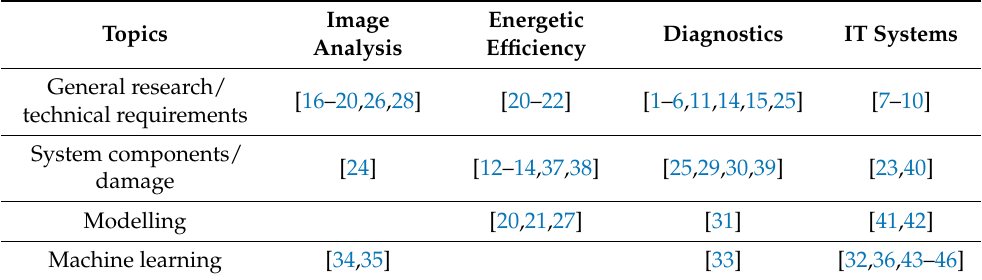
Table 1. Topics that arise in a literature review on railway elements